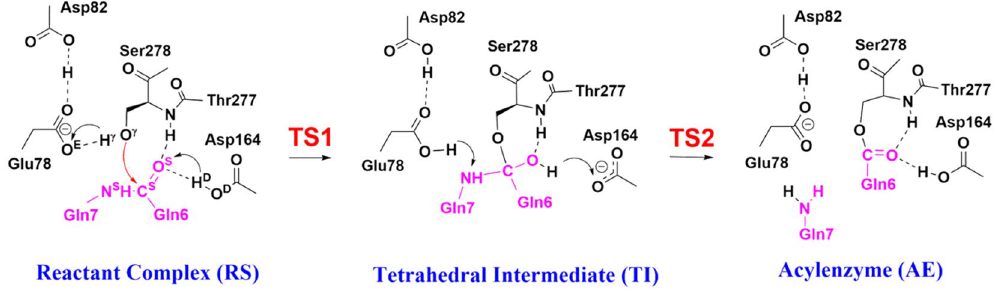
Figure 1. The proposed acylation catalytic mechanism of KumaWT, and Kuma030 complexed with a substrate peptide (PFPQPQQPF) and the role of important active-site residues. The reaction coordinates (RC) applied in this study are denoted as RC1 = r(O γ … H γ ) − r(O E … H γ ) − r(C S … O γ ), RC2 = r(O D … H D ) − r(O … H D ), and